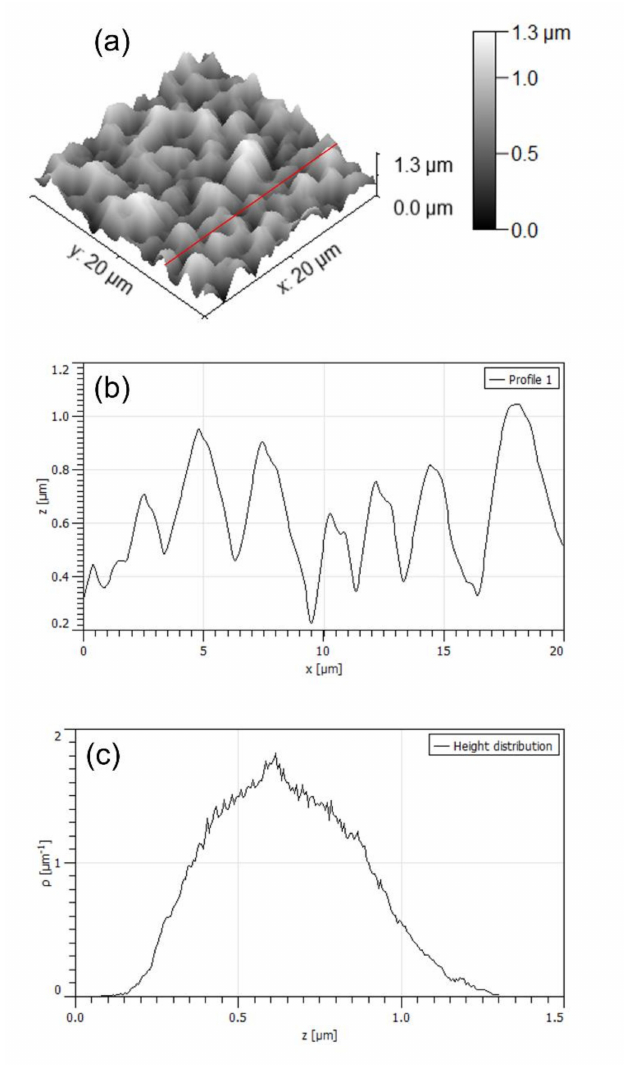
Figure 8. ( a ) Three-dimensional AFM image, ( b ) profile and ( c ) height distribution of the thiol-ene surface hot embossed at 100 ◦ C under 30 MPa and annealed at 100 ◦ C for 1 h. The red line indicates the location where the AFM profile was